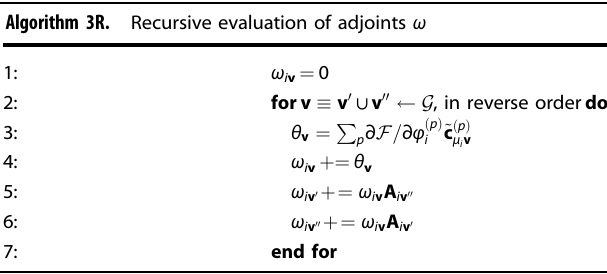
Algorithm 3R. Recursive evaluation of adjoints